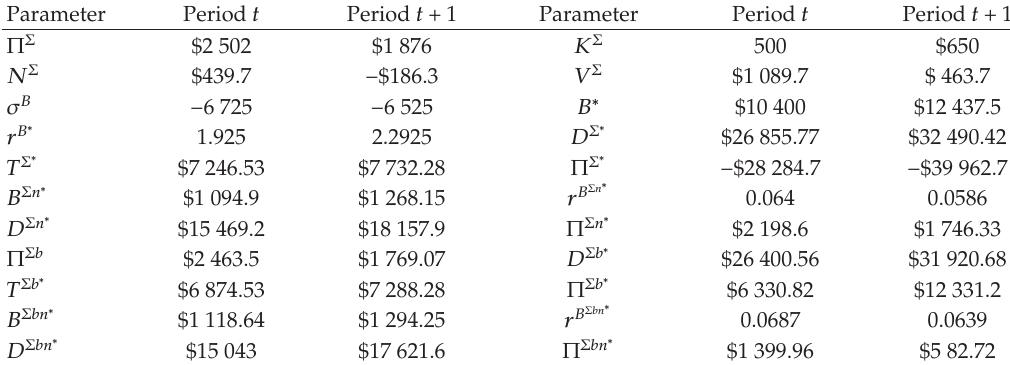
Table 5: Computed subprime mortgage securitization